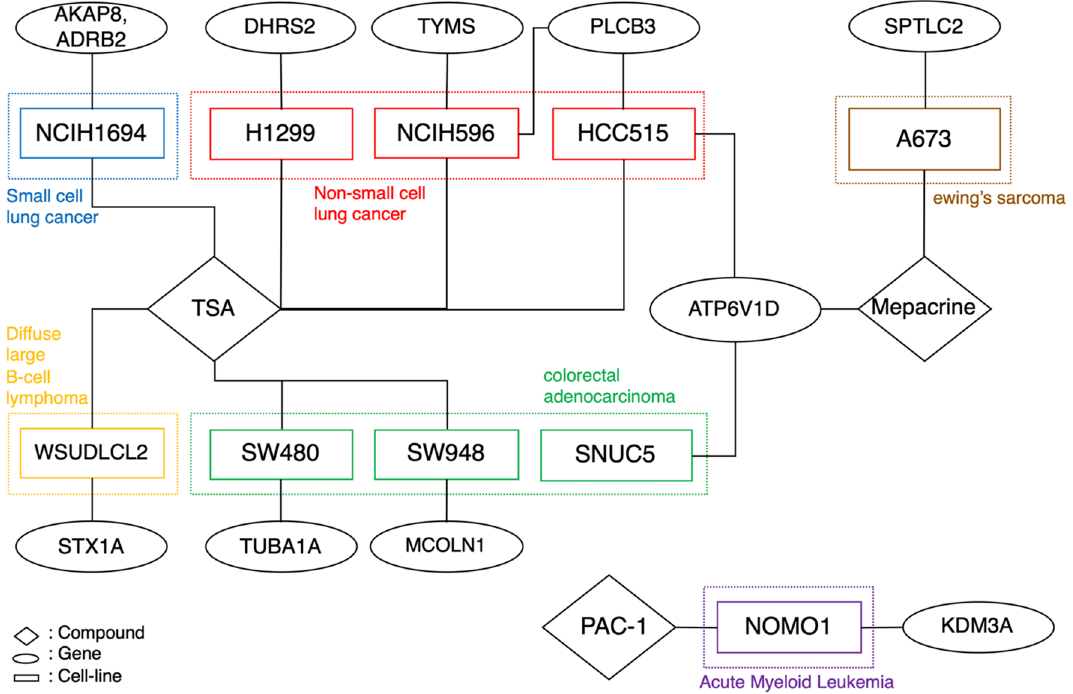
Figure 4. Cell line and chemical compound-specific patterns. The significant factor-specific patterns exhibiting both chemical compound- and cell-specific effects are